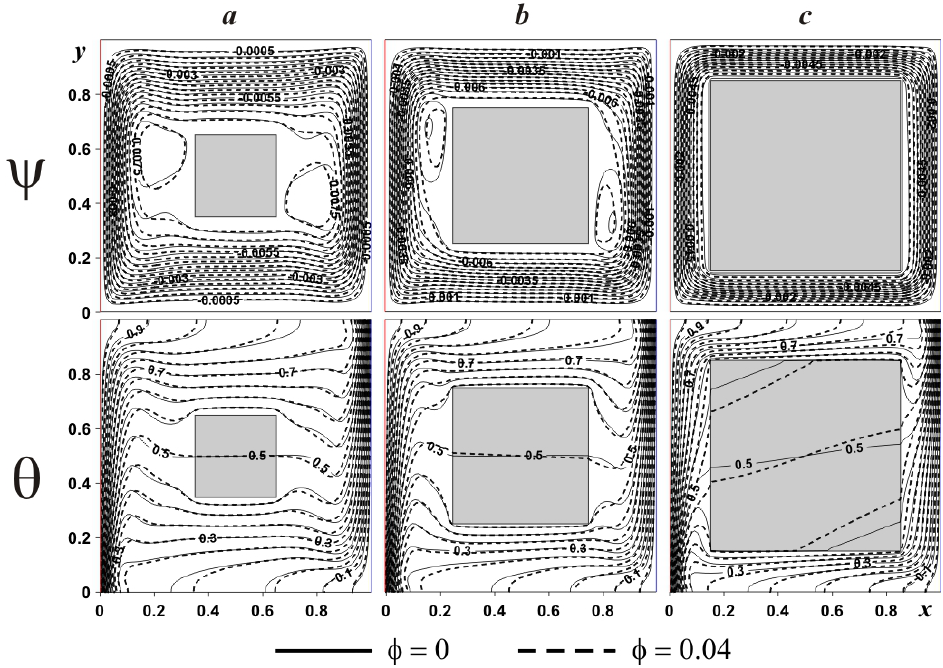
Figure 12. Isolines of ψ and θ for heat-conducting internal body at Ra = 10 6 and different δ and φ :